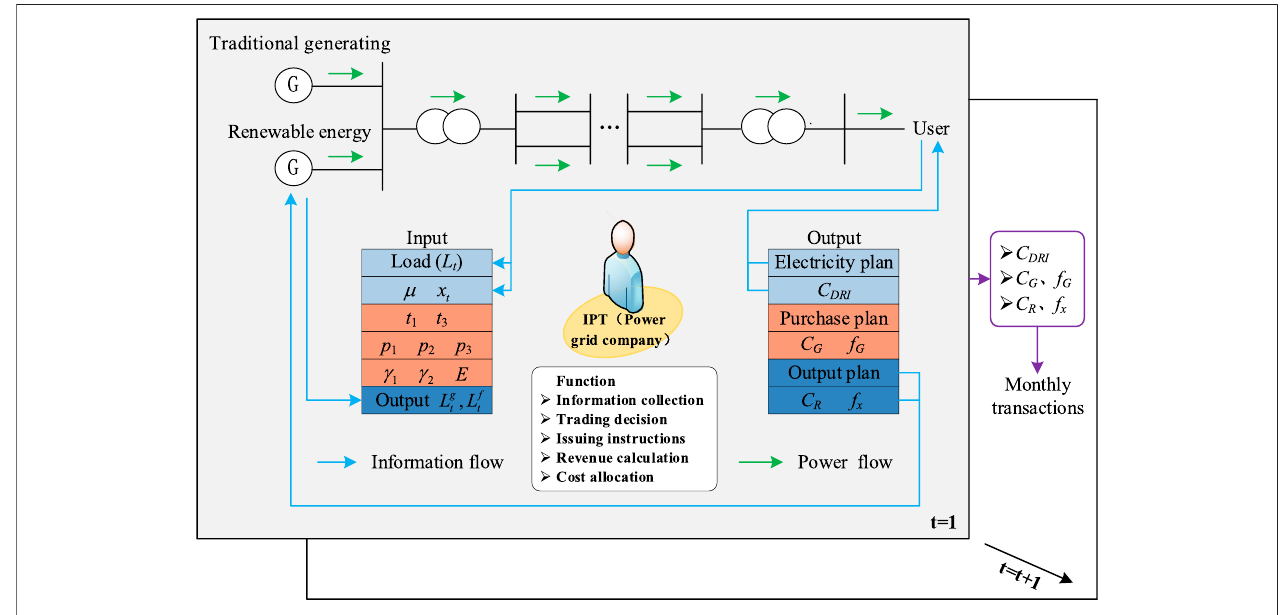
FIGURE 3 | Structure of monthly interprovincial transactions.